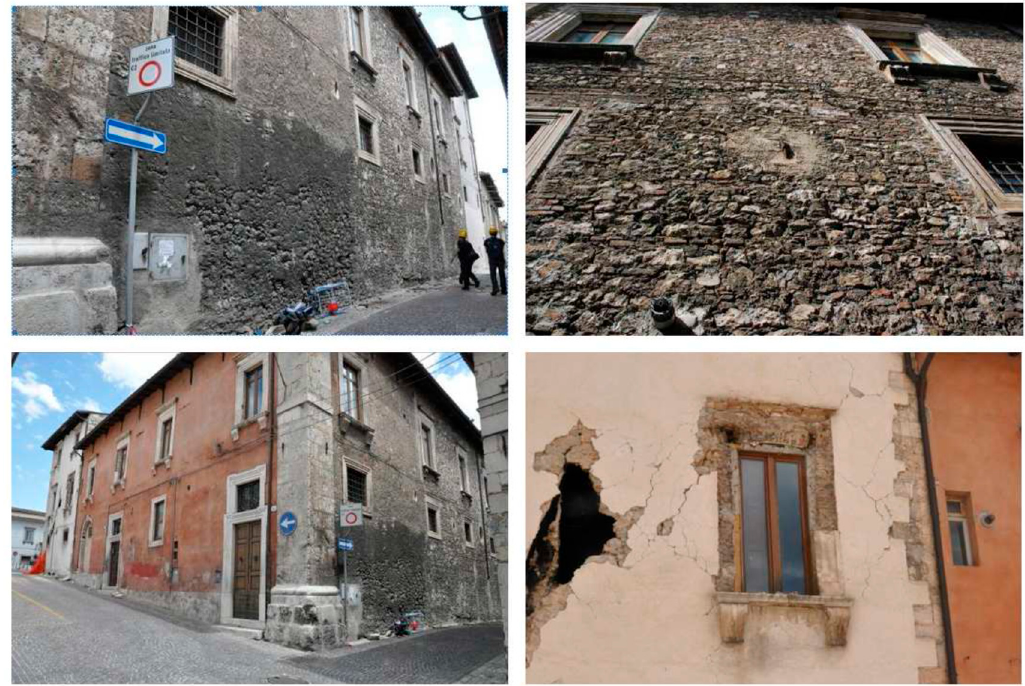
Figure 5. Some details of the masonry typologies. Reproduced with permission from [18].